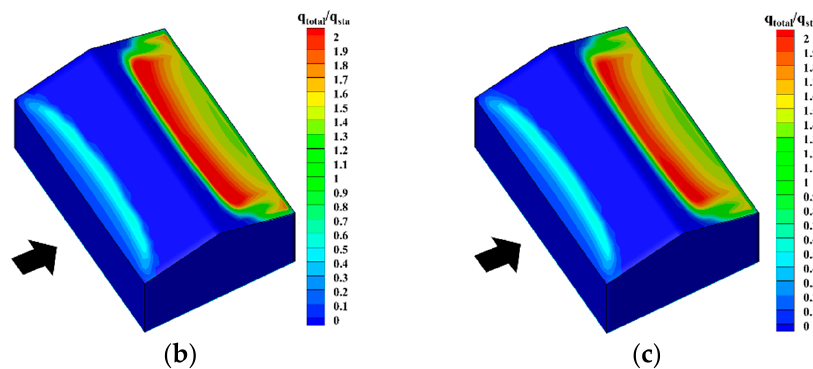
Figure 23. Spatial distribution of the normalized total deposition flux q total / q sta with different snowfall intensities: ( a ) volume fraction: 7.8 × 10 − 6 ; ( b ) volume fraction: 1.56 × 10 − 5 ; ( c ) volume fraction: 2.34 × 10 − 5 .